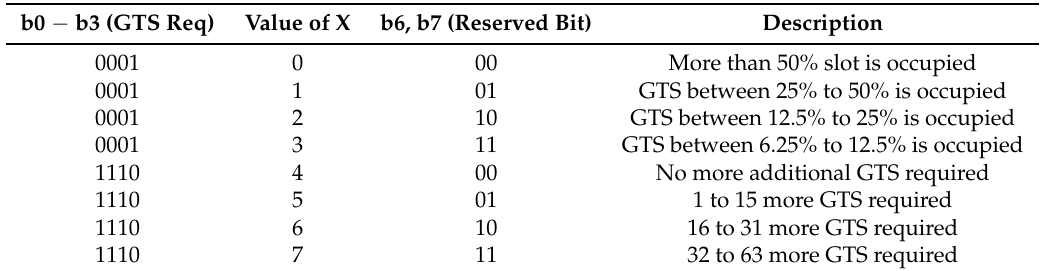
Table 1. Parameter values describing slot